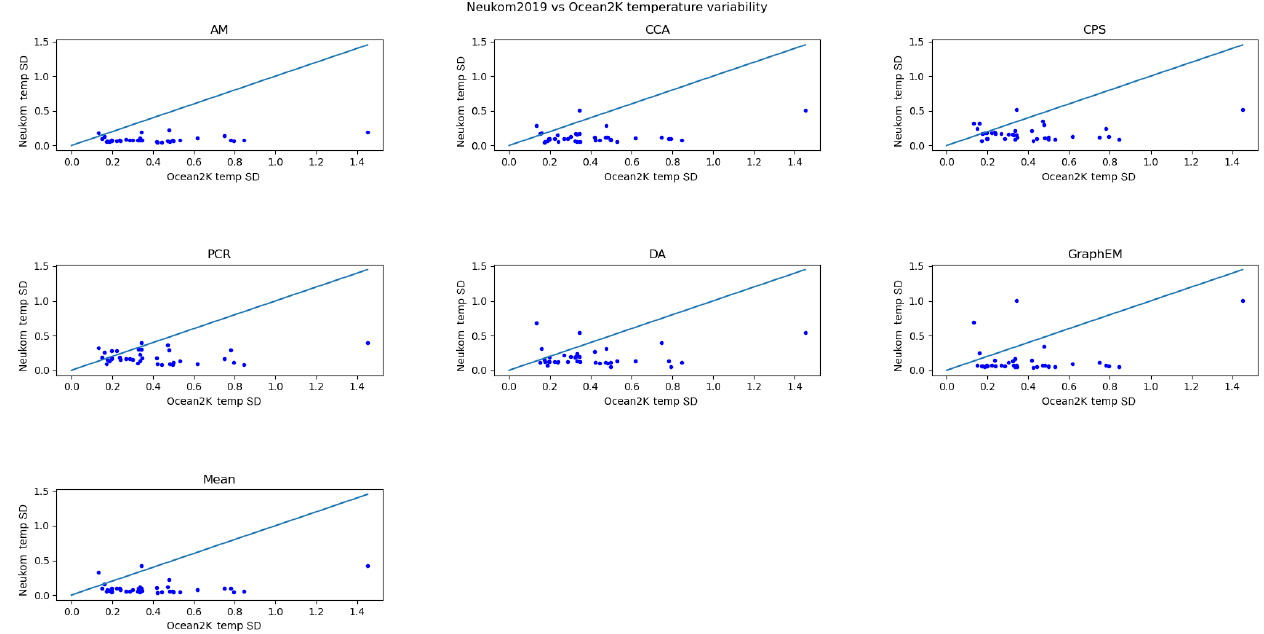
Figure A10. Local Ocean2K (McGregor et al., 2015) SST variability versus PAGES-2k data (Neukom et al., 2019) temperature variability at the same sites for the different CFR methods.